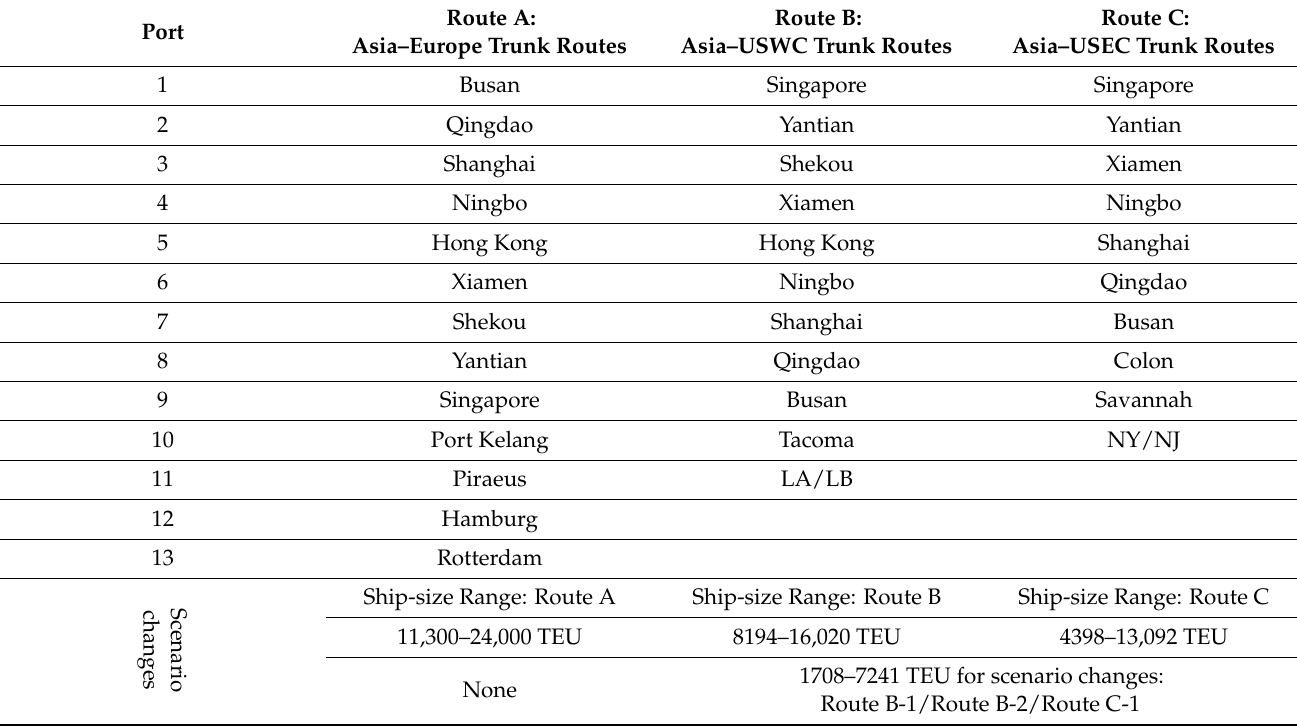
Figure 1. The major East–West trunk routes for estimated carbon intensity. Table 4. Calling ports and ship size range on route A/B/C.